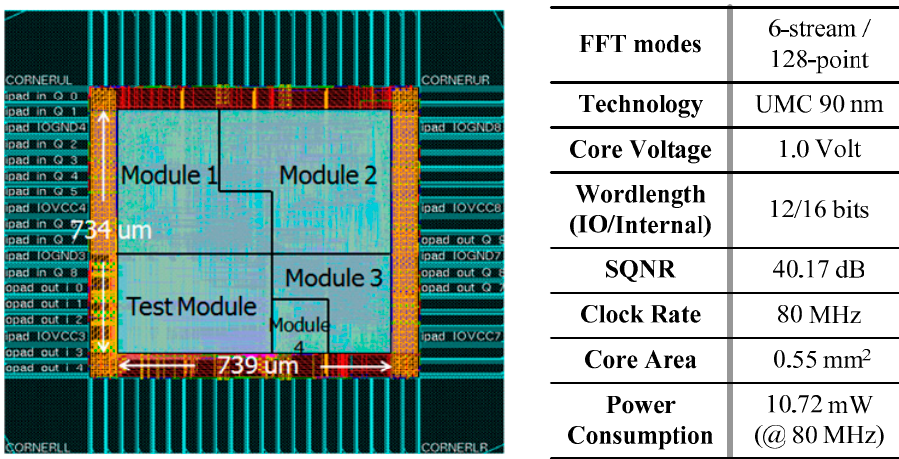
Figure 15. Layout and performance summary of FFT kernel test chip.